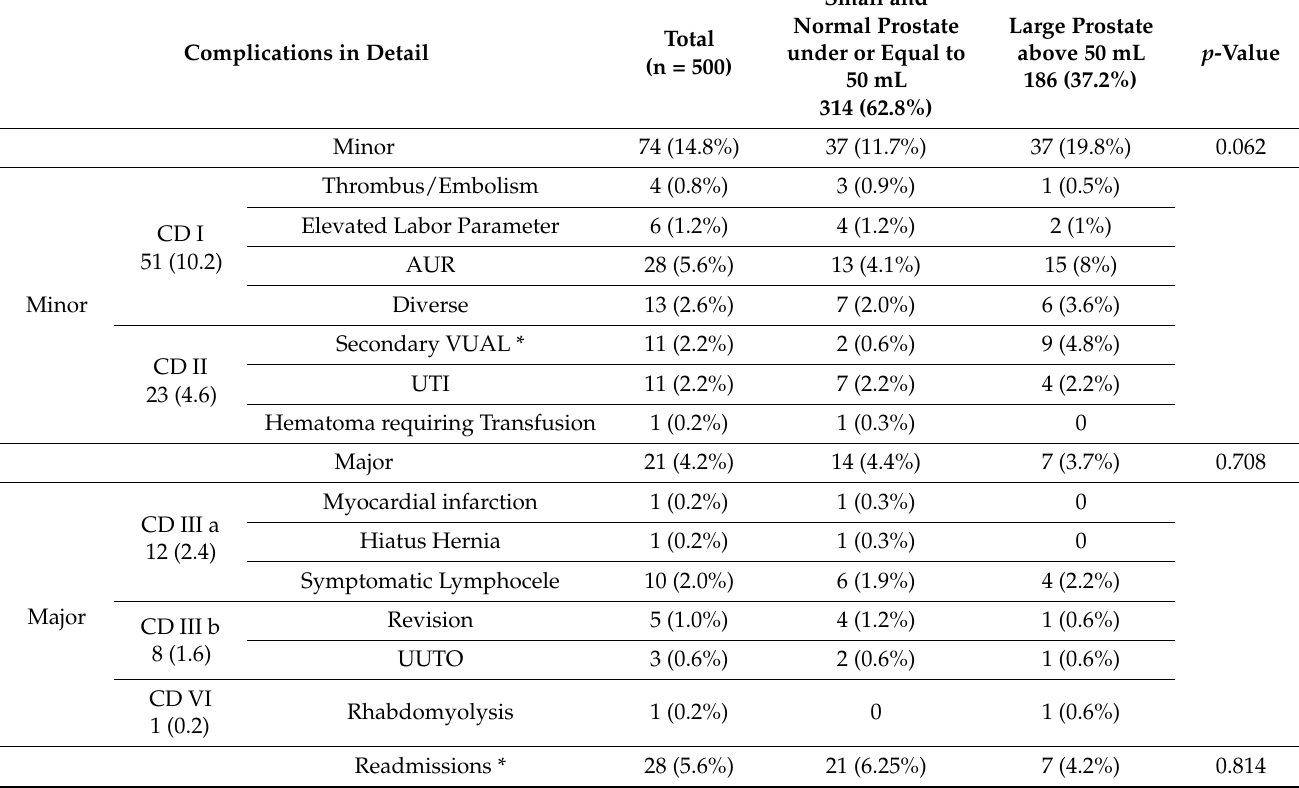
Table 3. Thirty day complications and